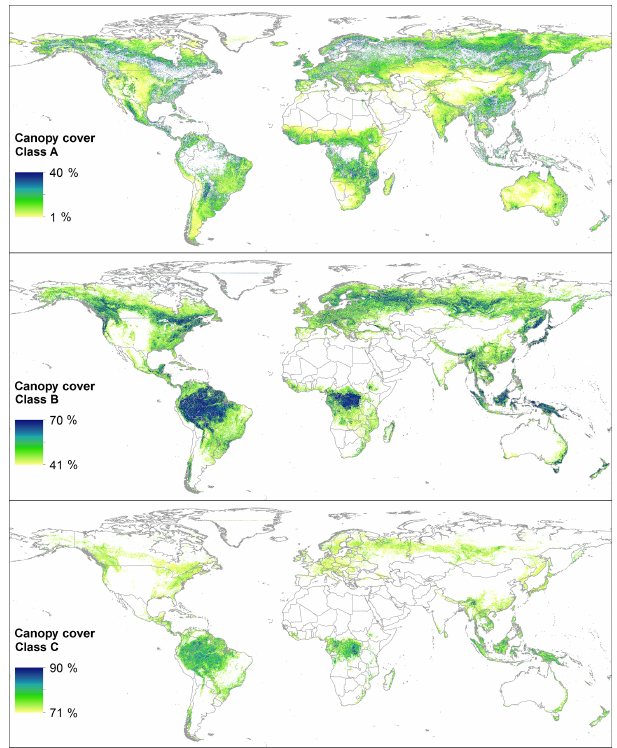
Figure 4. Percentage canopy cover, derived from the MODIS VCF Collection 5 product. The maps show the subdivision of the CC into the three classes considered for